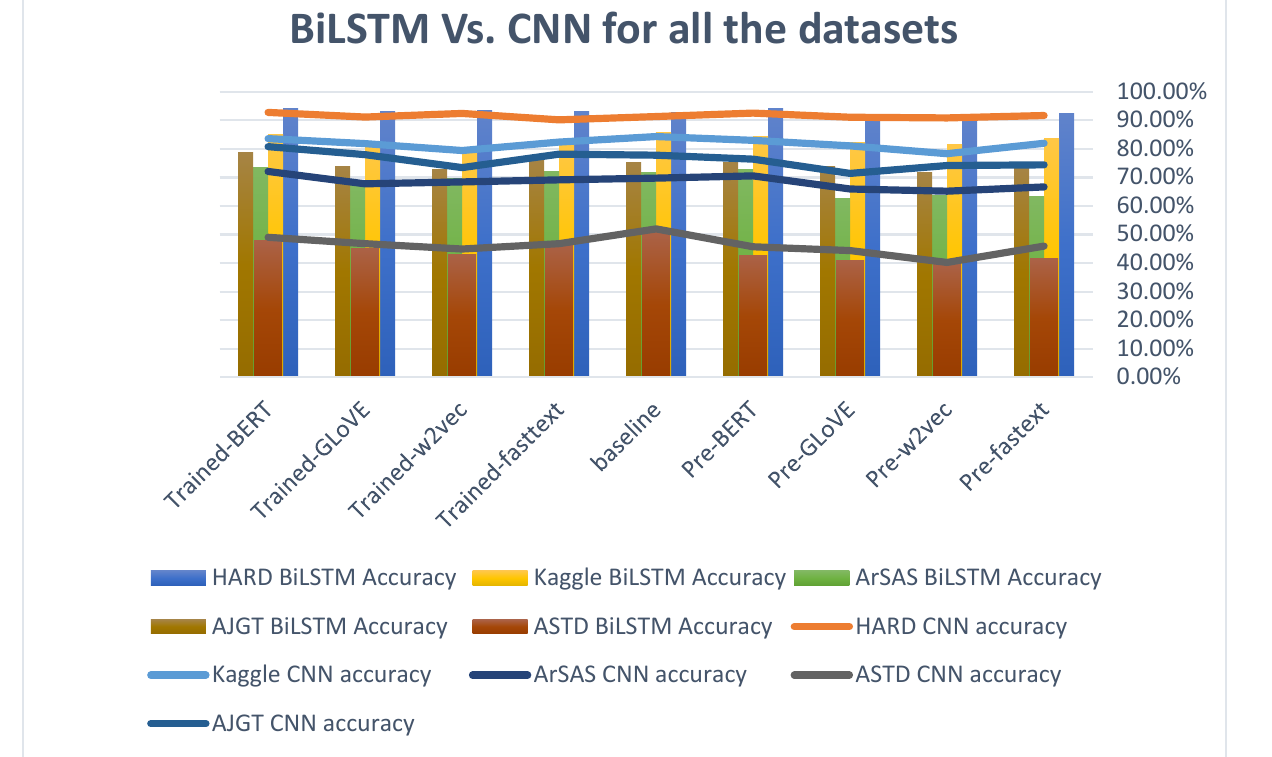
Figure 3. The accuracy of BiLSTM vs. CNN for different datasets.